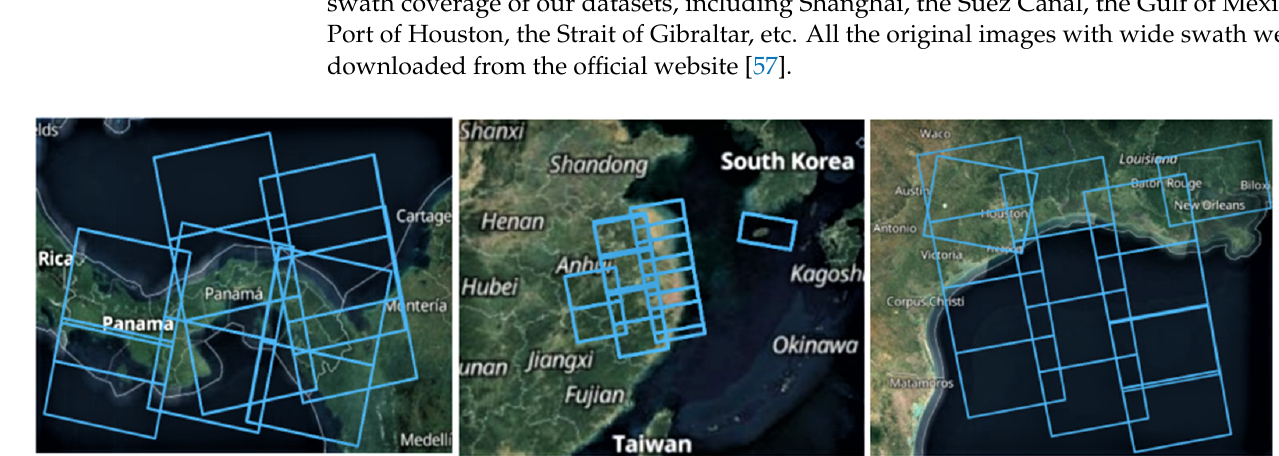
Figure 1. Representative regions acquired from the Sentinel-1 IW. Blue boxes indicate the coverage of each image. Table 1. Detailed information for the original Sentinel-1 imagery.